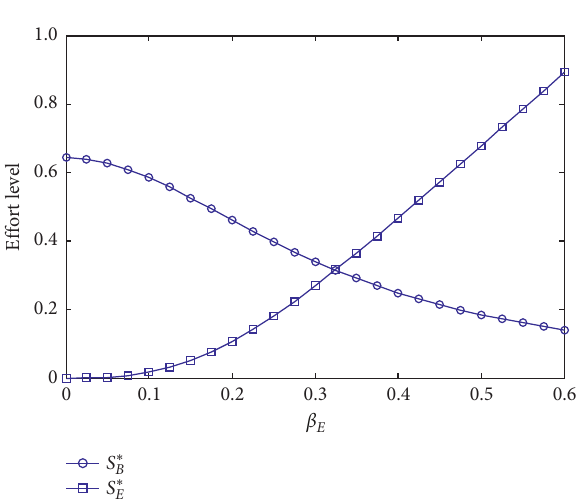
Figure 4: Changes of S ∗